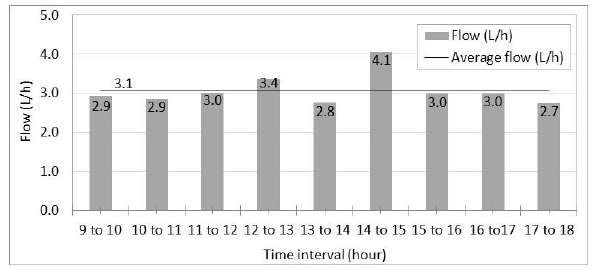
Figure 2: Volume of condensed water produced during the opera- tion of the air condenser